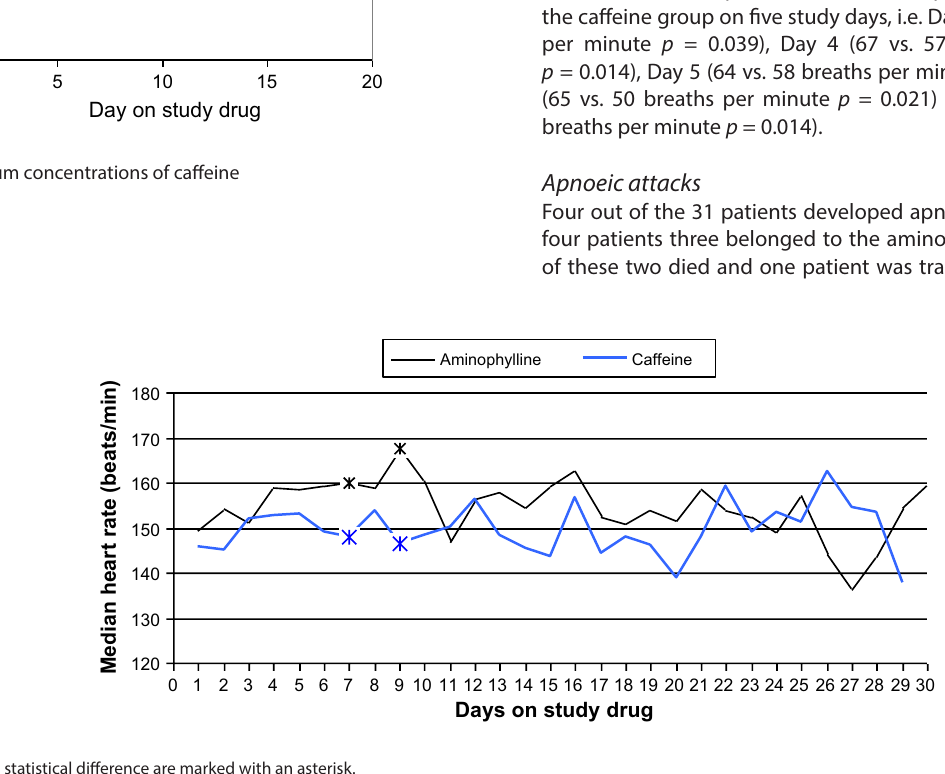
Note: Days with statistical difference are marked with an Figure 4: Median heart rate in the two study groups